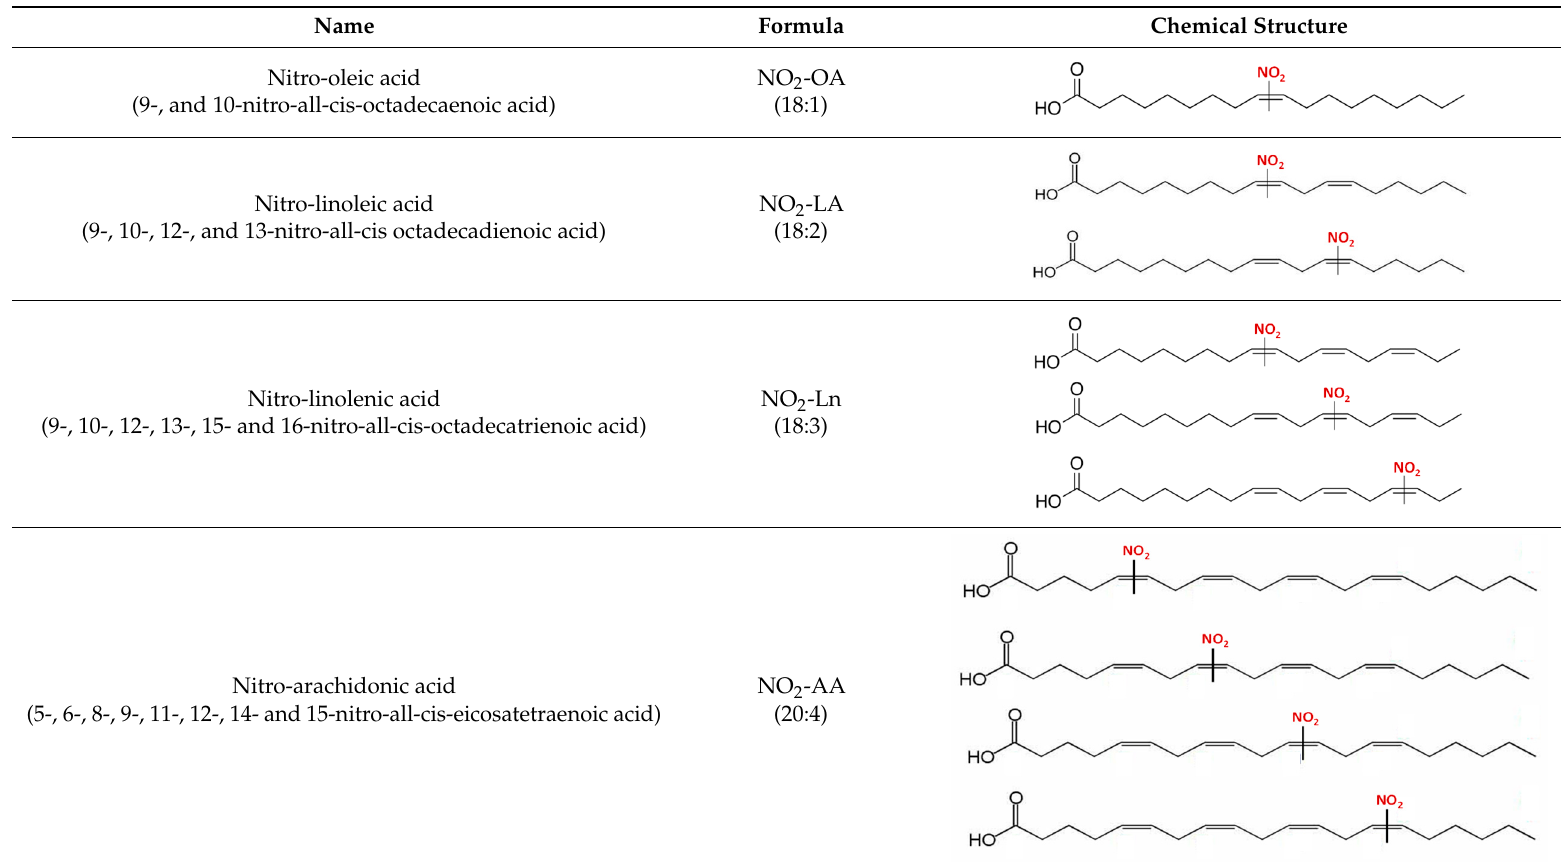
Table 1. Principal nitro-fatty acids detected in animal and plant systems. The lines on the middle of the double bond indicate that the nitro group could be bounded in any of the adjacent carbons. Although double bonds can generate the corresponding cis- and trans-isomers, only the cis forms are shown.